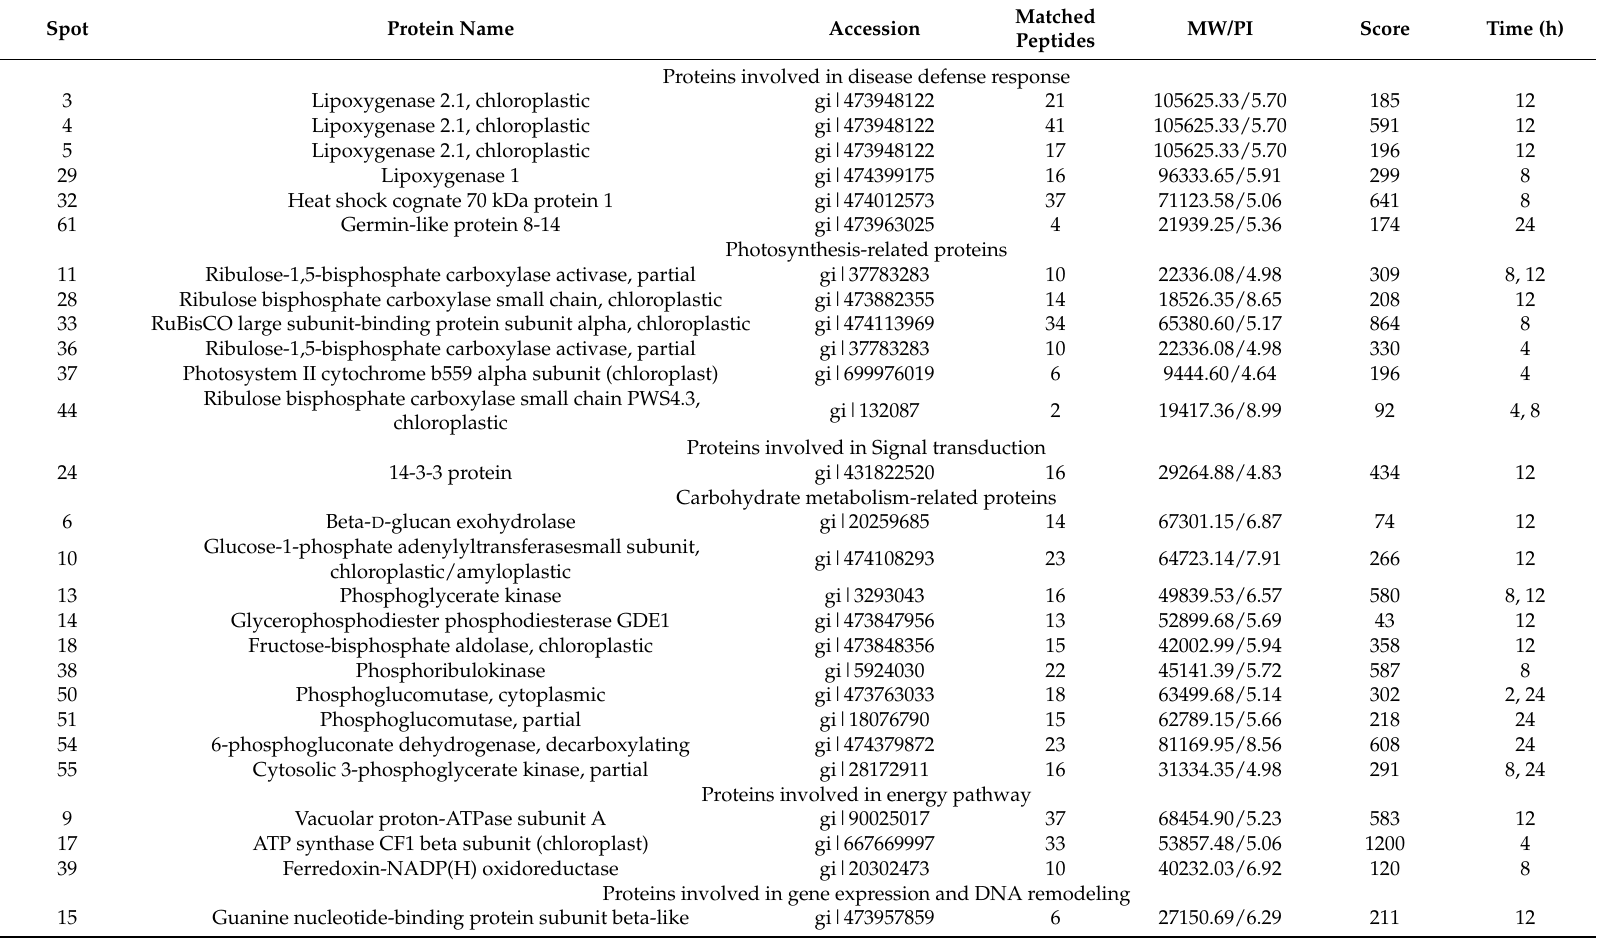
Table 1. Identification of differentially upregulated proteins in wheat resistance cultivar L699 by